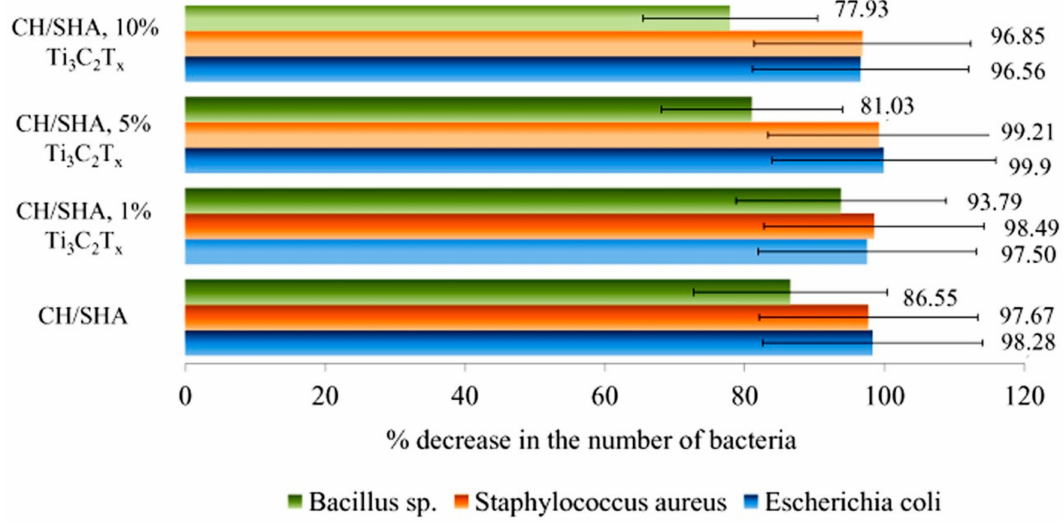
Figure 6. The e ff ectiveness of the tested hydrogels in the elimination of bacteria in liquid